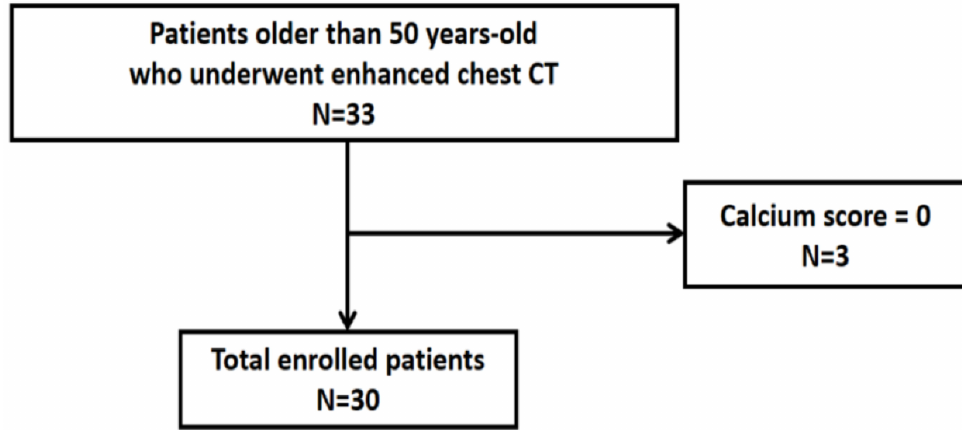
Figure 1. Flow chart of patient